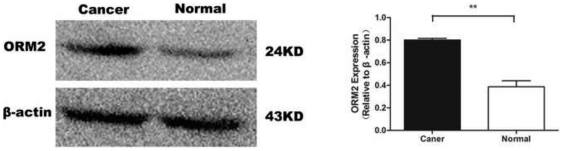
Expressions of ORM2 in CRC and corresponding adjacent normal mucous tissues by Western blot analysis (The sign with three stars mean P<0.01).